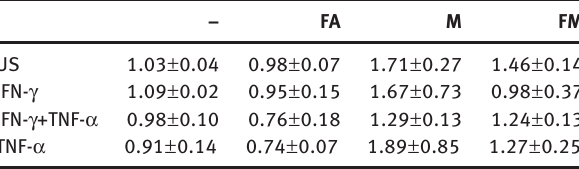
Table 1 Homocysteine concentrations ( μ mol/L) measured in the supernatants of unstimulated (US) and stimulated. (IFN- γ , interferon- γ ; TNF- α , tumor necrosis factor α ) Human